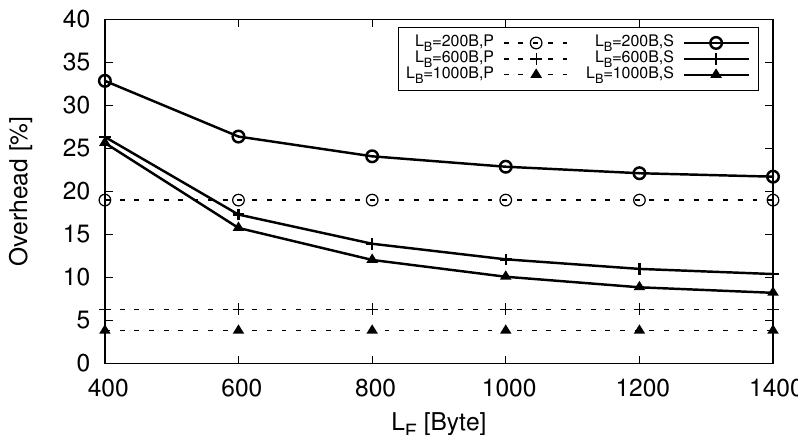
Figure 9. Overhead for backhaul (BH) packets as a function of payload length L F for different BH packet length L B using CPRI opt. 6. Solid lines for the case with segmentation (S), dashed lines for the no-segmentation case (P).